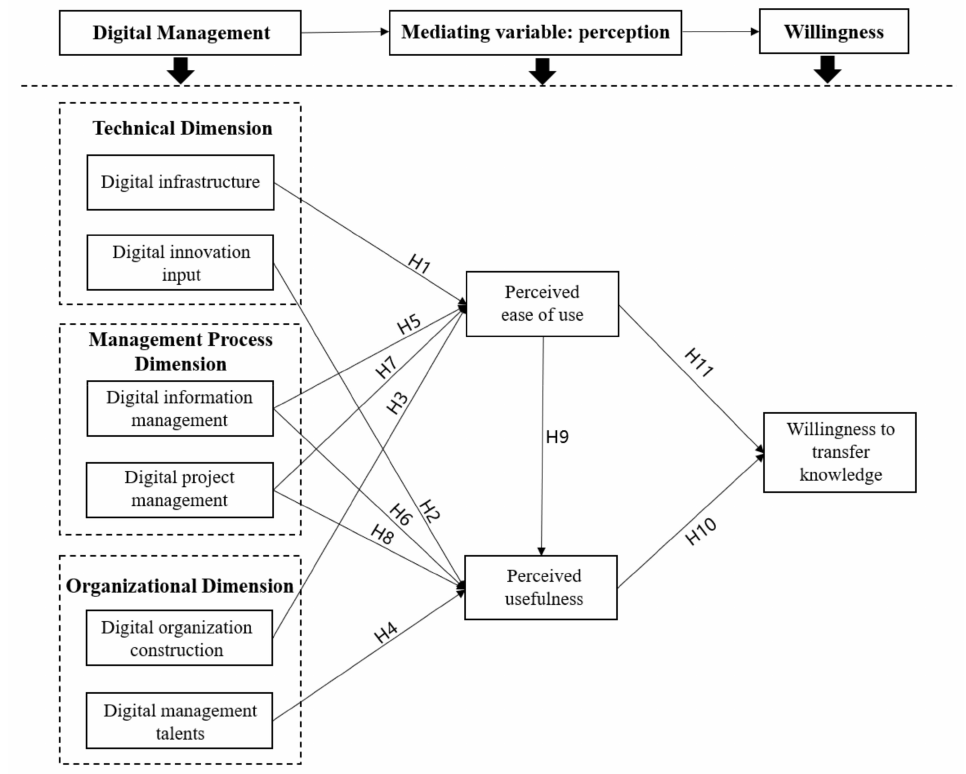
Figure 3. The Conceptual Model of the Impact of Digital Management on Willingness to Transfer Knowledge in Engineering Consulting